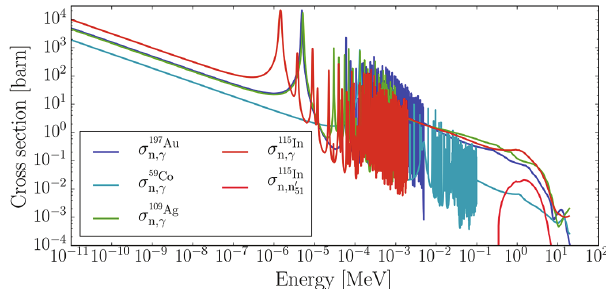
Fig. 3. Cross section of interest of different foil